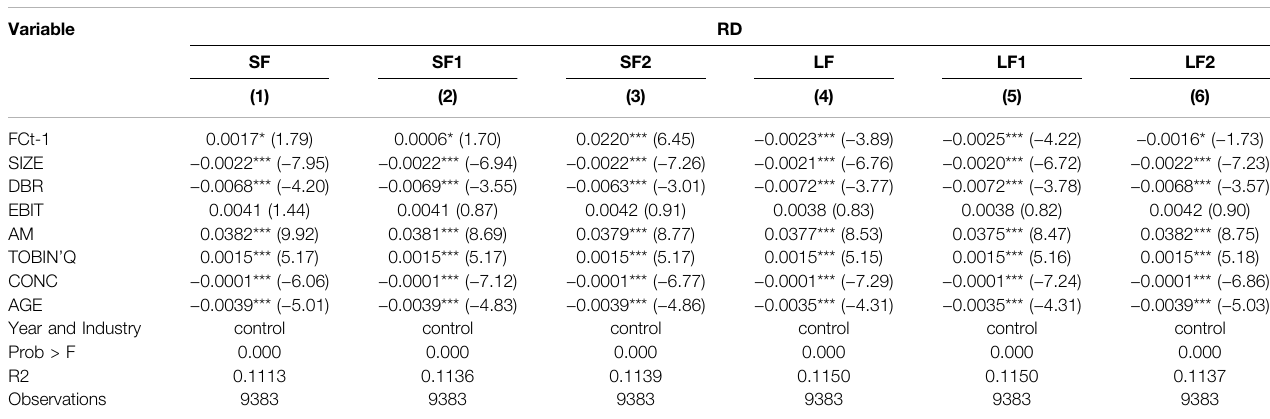
TABLE 8 | Regression results of fi nancialization on R&D expenditure after one period lag.